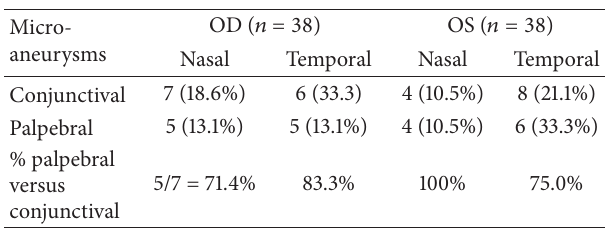
Table 3: Presence and location of microaneurysms in group A (Fabry) patients.